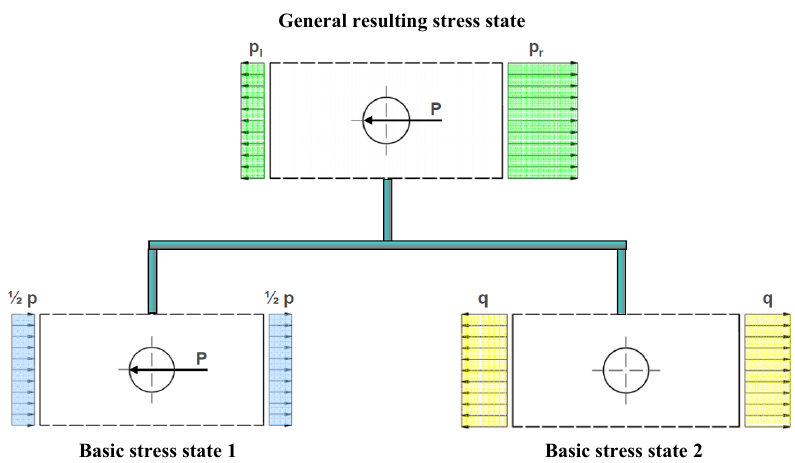
Figure 2: Linear combination of the two basic stress states for calculation of the global resulting stress